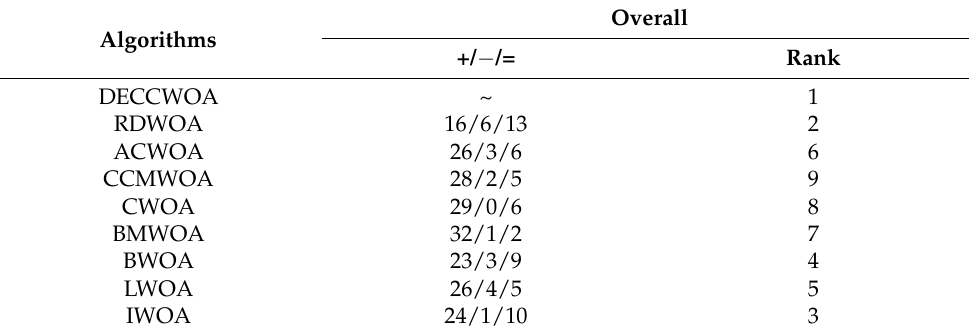
Table 5. Comparison results for DECCWOAs with improved WOA